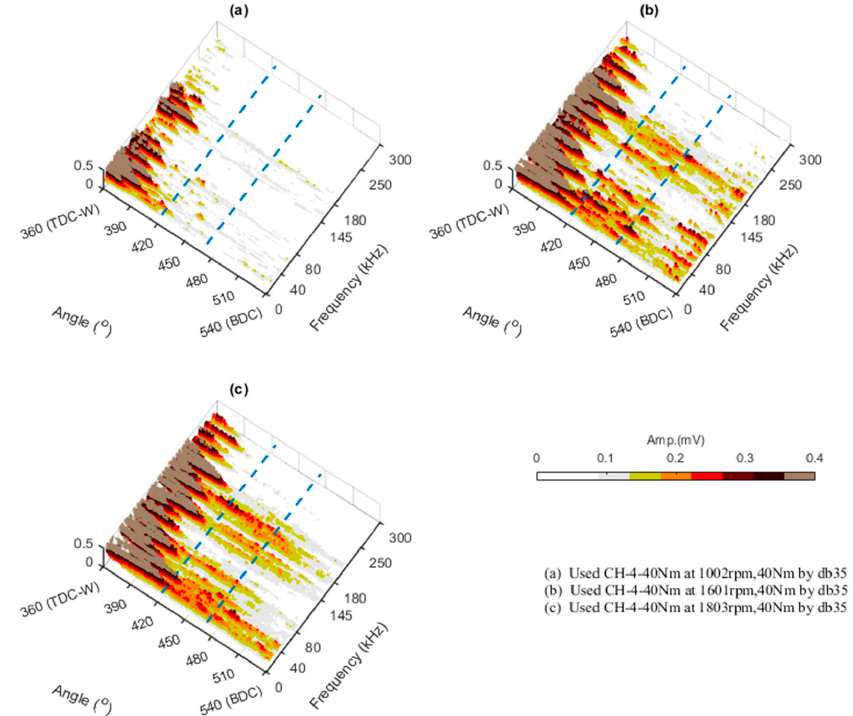
Figure 13. AE WPT spectra in power stroke for the used oil at different speeds and high load.